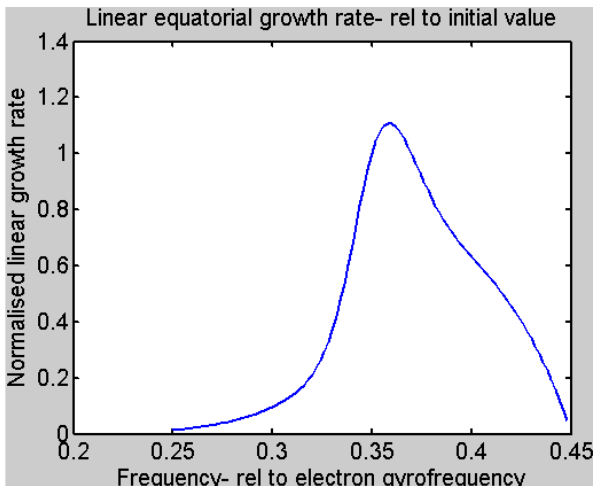
dicular velocity space.